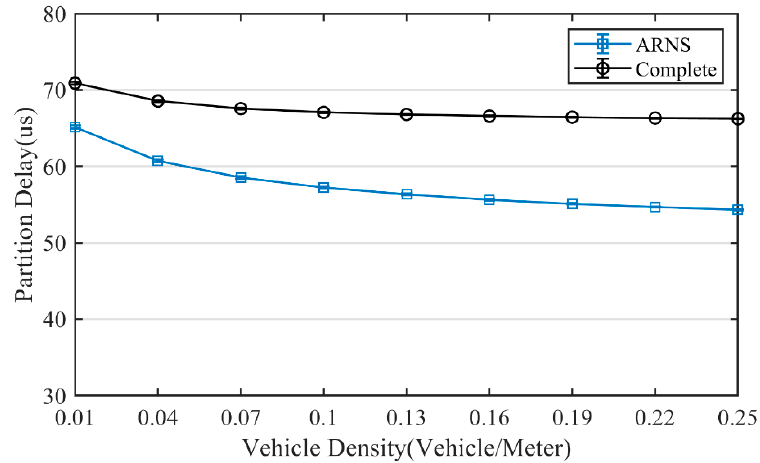
Figure 7. Broadcast coverage.